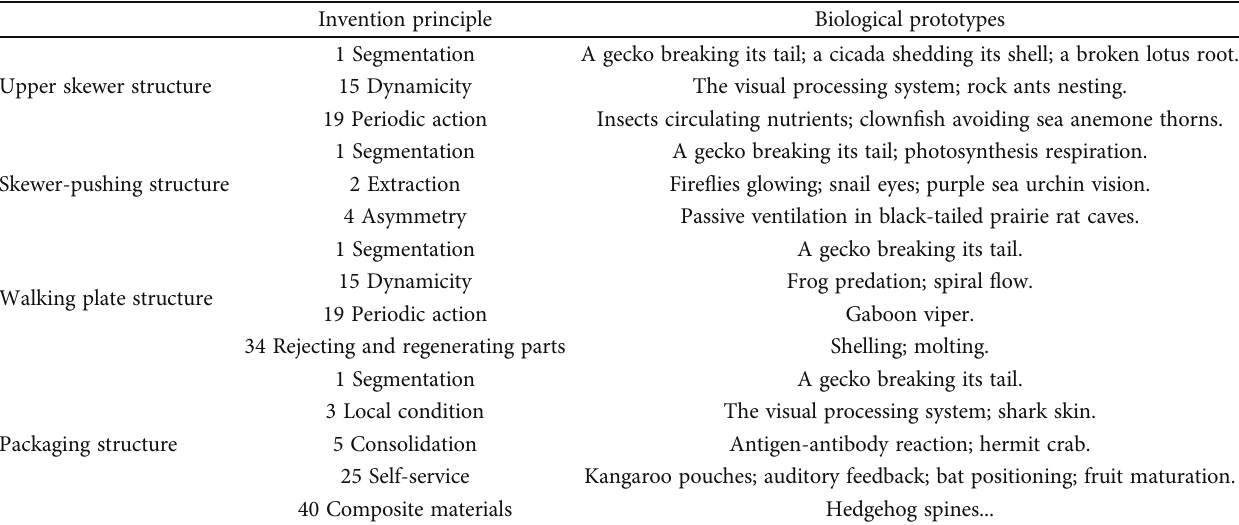
Table 2: The invention principles corresponding to the structures and biological prototypes.